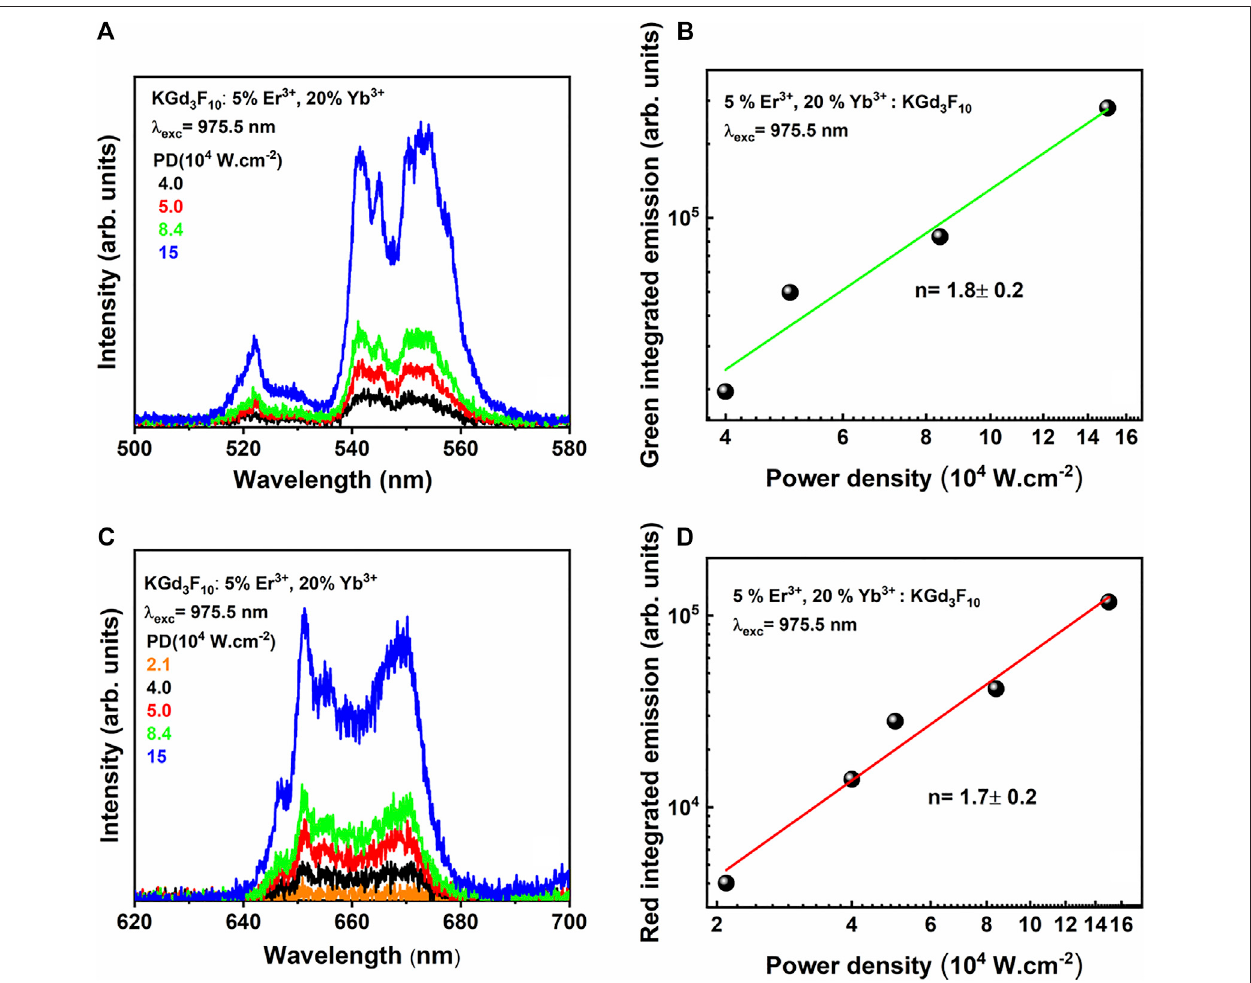
FIGURE9| UCgreen (A) andred (C) emissionspectraofasingleEr 3+ ,Yb 3+ :KGd 3 F 10 NPuponvaryingthepowerdensitiesat975.5 nmandlog-logplotoftheUC spectrum area of the green (B) and red (D) emissions as a function of the power densities of the same individual NP.